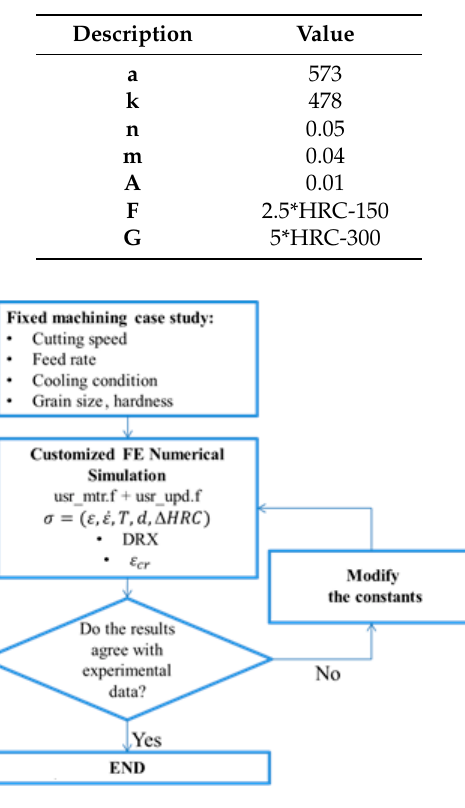
Table 1. Calibrated numerical constants and factors.